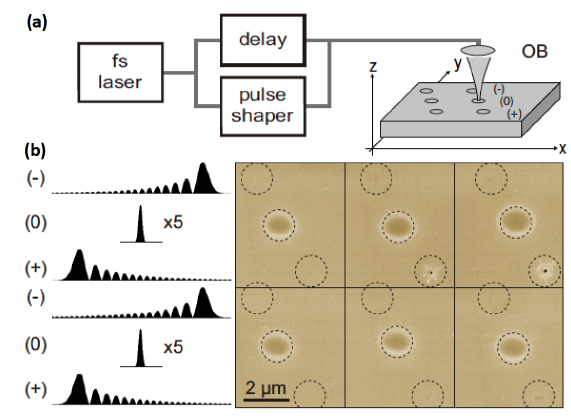
Figure 17: (a) Schematics of experimental setup and fabrication pro- cedure. For material processing, the pulse energy in the x-direction was increased in steps of 6 nJ and the focal z position in the y- direction was changed by 1 µ m. For each setting, three laser pulses were applied, all having the same energy: one with negative cubic phase ( − ), one unshaped (0), and one with positive cubic phase ( + ) depicted also by the dotted circles in (b), where they indicate diffraction limit. (b) Transient laser intensities and corresponding SEM images of a subset of laser-generated structures in fused silica obtained by the procedure described in (a). Top row: surface in focal plane; lower row: surface 1 µ m below focal plane. The large struc- ture (dark color parts) in all areas is due to the unshaped pulses (0) and their size is close to the diffraction limit. The small holes are created for positive cubic phase ( + ) in the middle and right photos of the top row. In contrast, negative cubic phase, that is, the time reversed pulse, does not induce any visible change [133]. Repro- duced with permission from The Optical Society of America, © 2012 by The Optical Society of America.